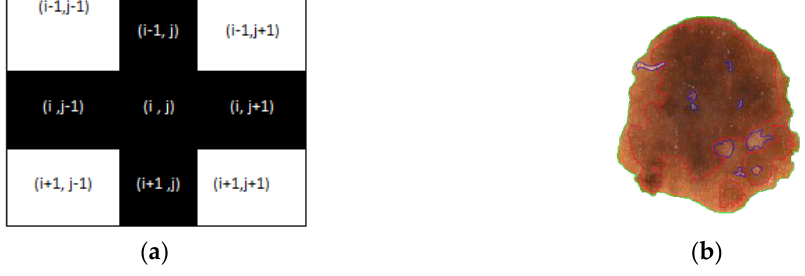
Figure 11. A sample representation of ( a ) plus operation and ( b ) mapping of all color variations within the segmented lesion .